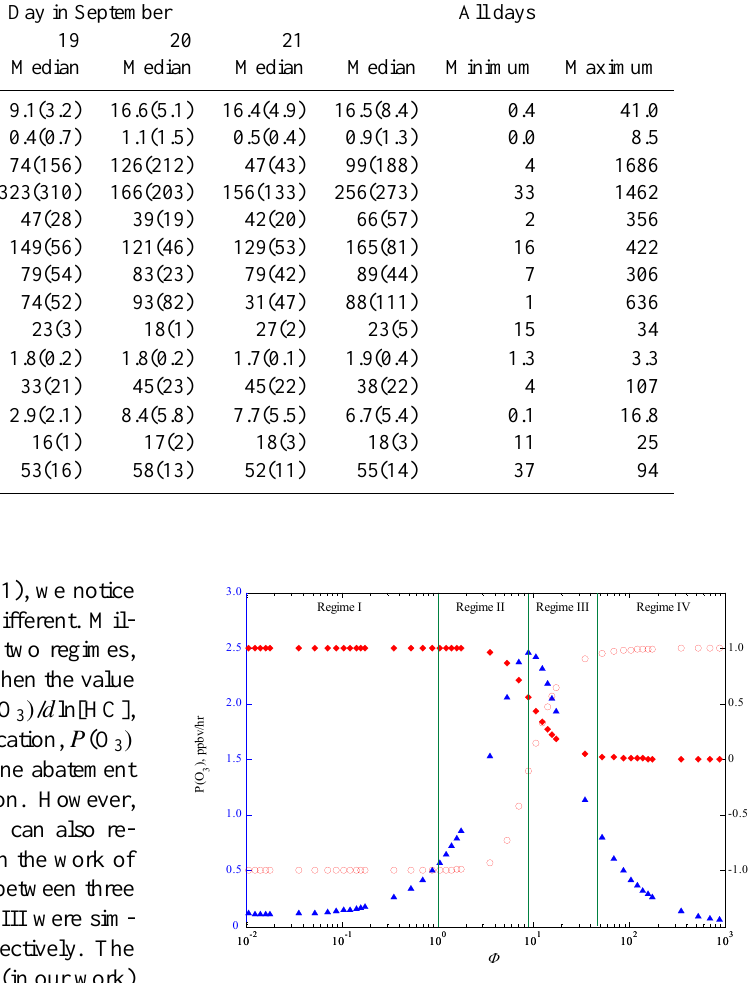
Fig. 4. Dependence of d ln P (O 3 ) / d ln[NO] (shown by open circle), d ln P (O 3 ) / d ln[HC] (shown by square) and P (O 3 ) (shown by triangle) on Φ at 1150 JST of 18 September.